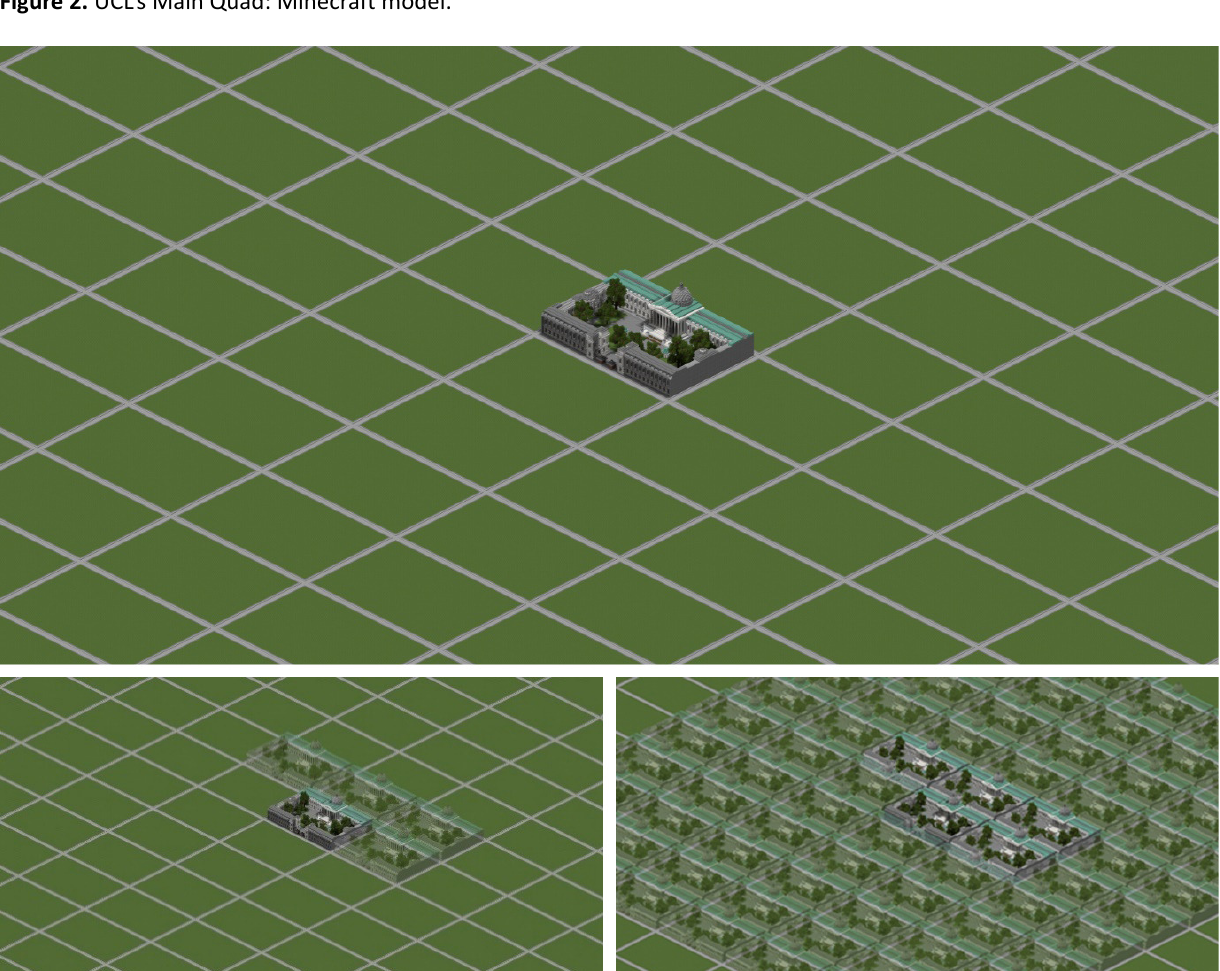
Figure 3. Workshop server, plots